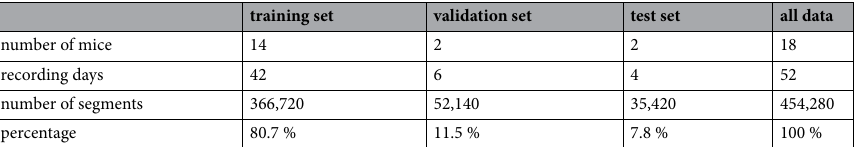
Table 1. Characteristics of the dataset. Data from 18 mice were split into three disjunct sets (training, validation, and test set). To allow for robust assessment of generalization performance of our networks out- of-sample, data of each mouse was assigned to only one of these sets. Each recording was further split into segments of 10 seconds for which sleep stages (labels) were